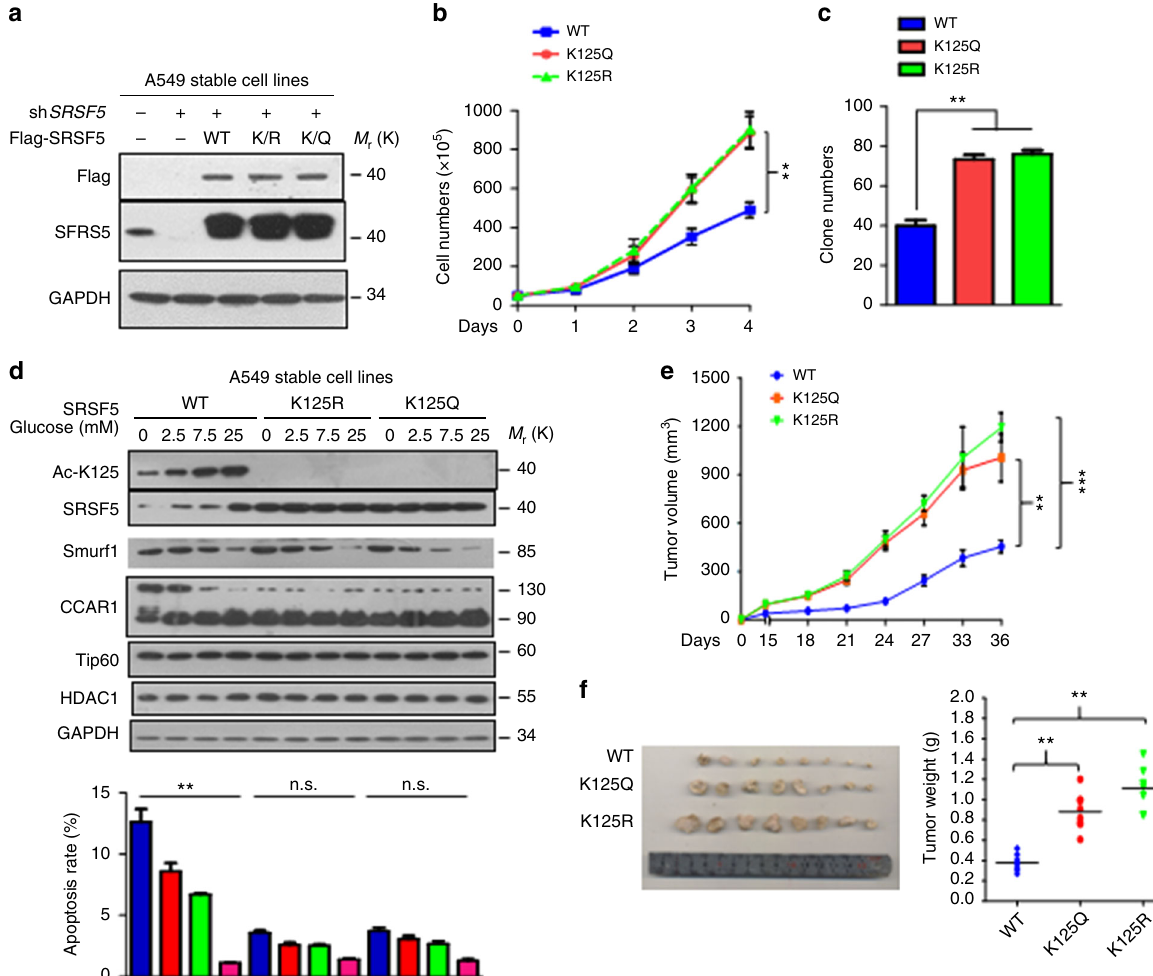
Fig. 9 K125 mutants of SRSF5 promote tumor cell growth. a Veri fi cation of A549 stable cell lines. Knockdown ef fi ciency and re-expression levels of wild- type or K125R/Q mutants were determined by immunoblotting. b K125R or K125Q A549 stable cell lines displayed higher proliferative rate than that of the WT cells. Cell numbers of indicated cell lines were counted every 24 h after seeding. Error bars represent cell numbers ± s.e.m. for triplicate experiments. The two-tailed Student ’ s t -test was used. ** P < 0.01. c Quanti fi cation of the number of colonies for A549 cells as described in b . d The apoptosis ratio